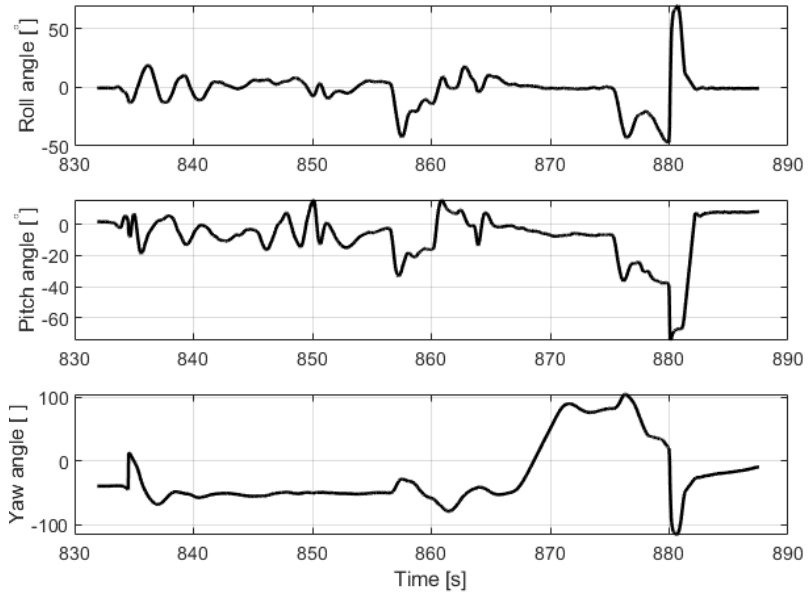
Figure 7. Roll, Pitch and Yaw angles of VTOL UAV during crash flight.